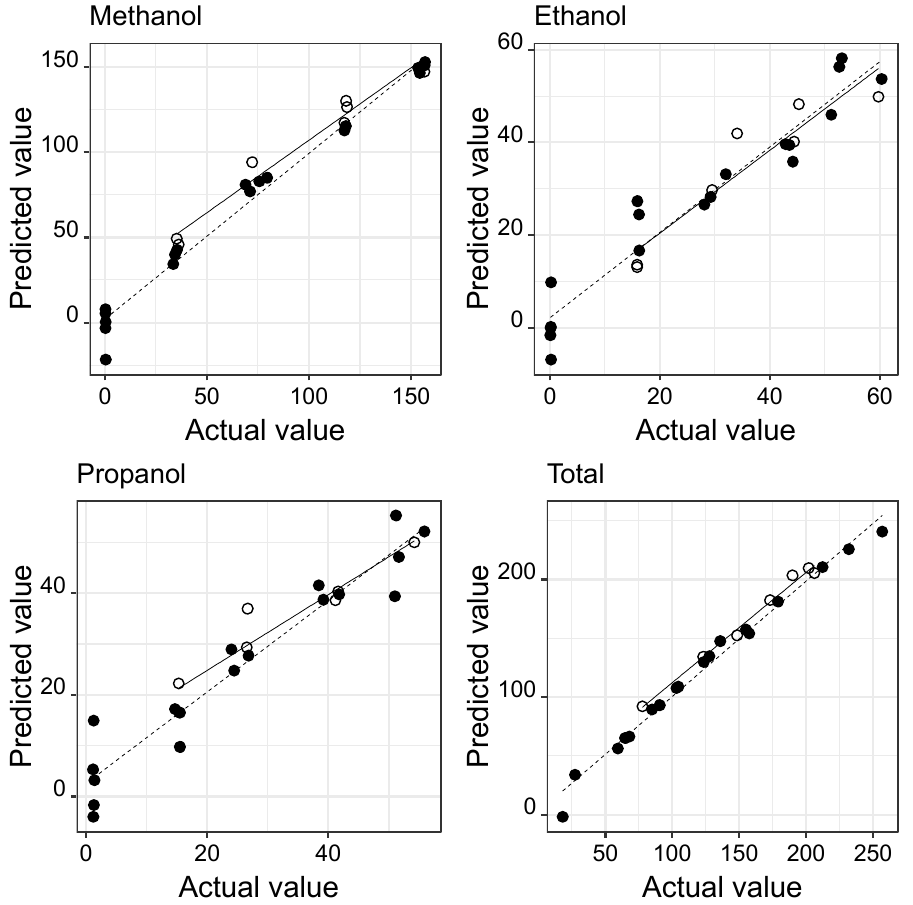
Figure 3. Enose predictive performance in relation to the expected concentrations (g/L) of the compounds in the mixtures of the 3 alcohol aqueous solutions and the total mass concentration (g/L) of these organic compounds; filled circles—training data; open circles—testing data.